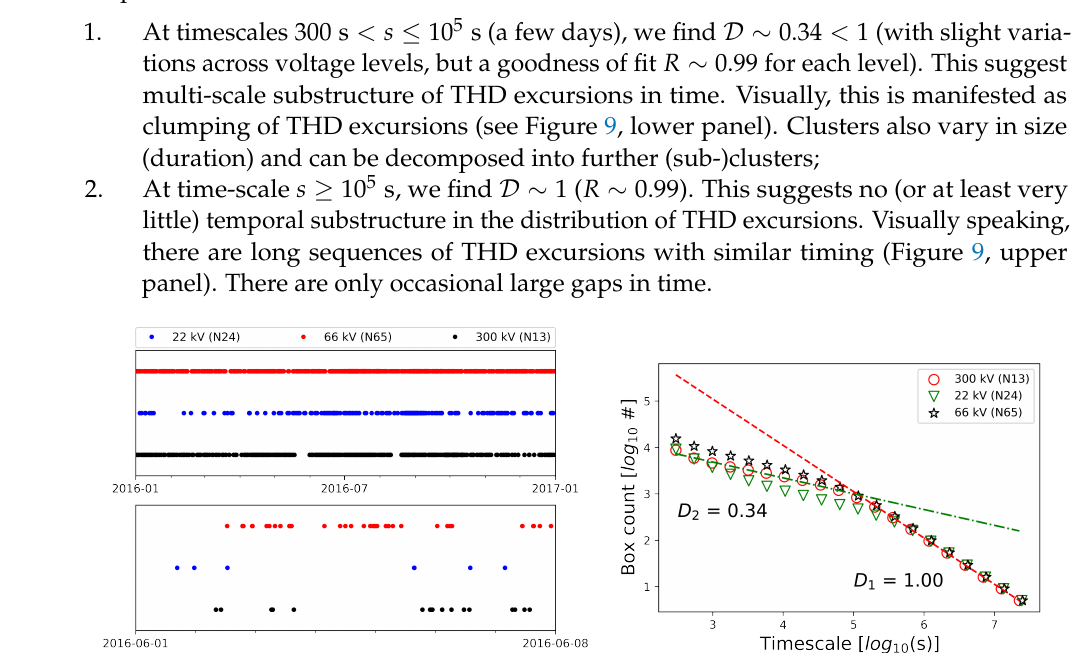
Figure 9. Left panel: Illustration of the temporal distribution of 99 percentile harmonic occurrence for all three sites spanning one year (top-left-panel) and one week (lower-left-panel). Lower time resolution in the figure is one minute. Right panel: Result from the application of the box-counting algorithm for determining the fractal nature of the distribution of the events in